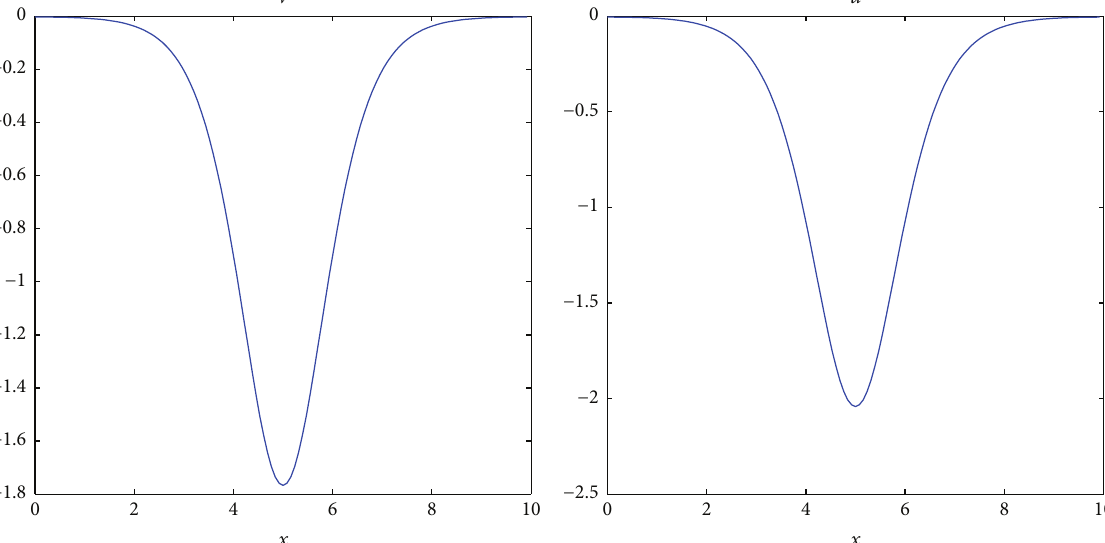
Figure 5: Periodic travelling wave solution of system (75) for 𝛼 = 𝛽 = 0.5 , 𝜎 = 0.5 , wave speed 𝑐 = 0.5 , and period 𝐿 = 10 , obtained after 12 Newton’s